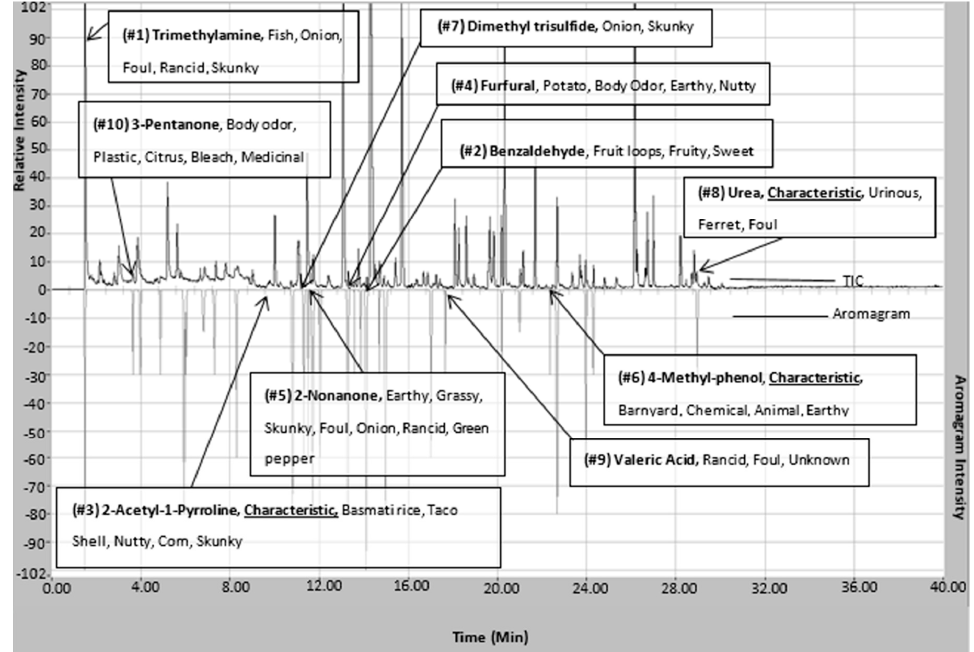
Figure 4. Chromatogram (top) and aromagram (bottom) resulting from simultaneous chemical and sensory analyses highlighting identified compounds in P. tigris altaica marking fluid responsible for the highest top 10 measured intense odors. Confirmation of compounds was performed via chemical standards for all listed compounds with the exception of 2-AP. 2-AP was confirmed using top five ions spectral match, retention time, and odor panelist observations. The odor characters listed are based on observed panelists’ evaluations.